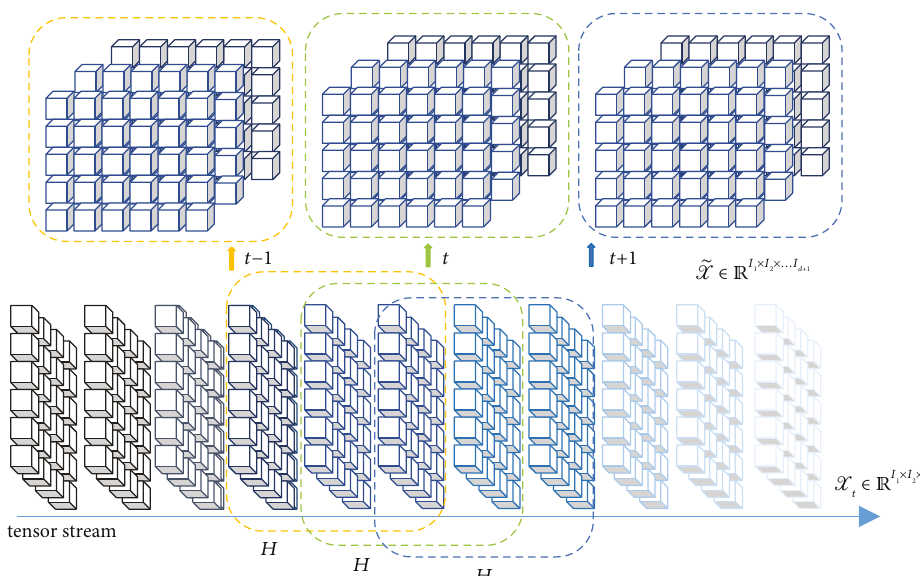
Figure 2: The divided tensor stream with a time